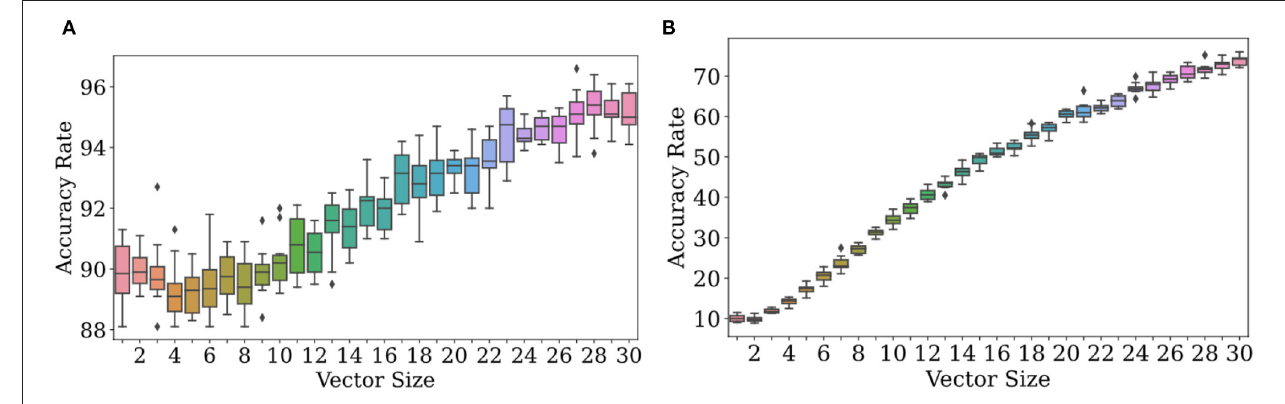
FIGURE 5 | Classification with priors and models that don’t match the environmental values can lead to increases in accuracy rate to near 100 % . Observations were generated with the environmental model given in Table 2 . For classification, the observer used the distributions given in the first two rows of Table 2 . (A,B) both show results of the trials where the simulated observer has an accurate grasp of the environmental distributions [ false observations. The prior probability is f